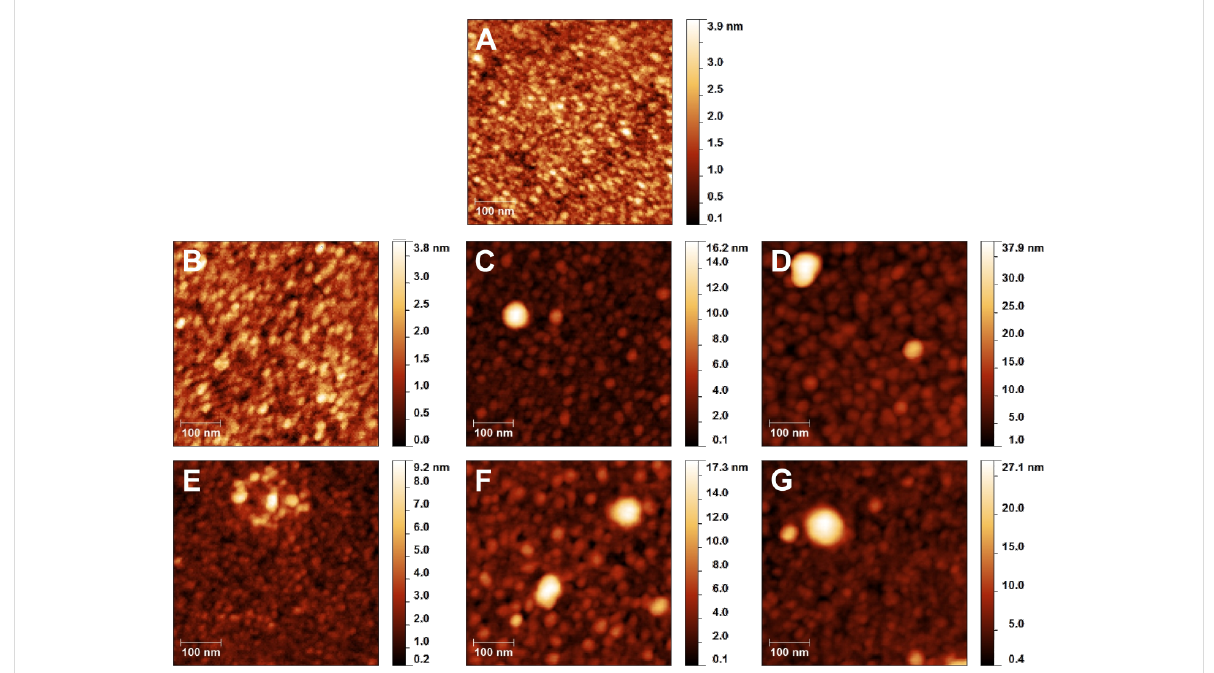
Figure 4: AFM images of the neat, flat titanium surface ( R RMS = 0.5 ± 0.3 nm) (A), and confluent anchor layers of neridronate ( R RMS = 0.5 ± 0.2 nm) (B), APTES ( R RMS = 1.1 ± 0.2 nm) (C) and PDA ( R RMS = 3.6 ± 1.2 nm) (D). The figure also reports AFM images of ALG layers grafted onto neridronate ( R RMS = 0.7 ± 0.3 nm) (E), APTES ( R RMS = 1.8 ± 0.2 nm) (F) and PDA ( R RMS = 2.9 ± 1.0 nm) (G) anchor layers. The AFM measure- ments on the ALG surfaces were performed on predominantly flat regions with R RMS values similar to those of the initial anchor layers.